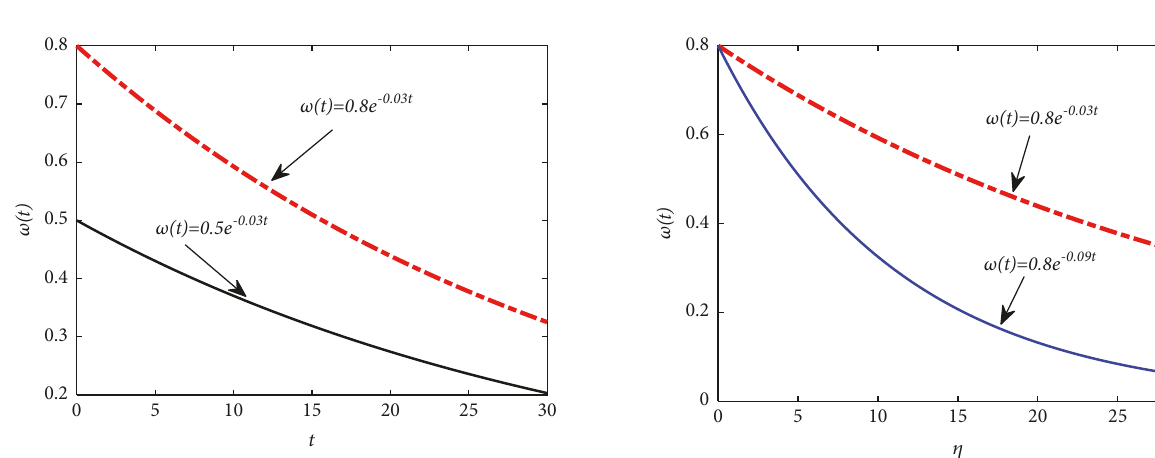
𝑇 𝐼(𝑝(𝑡), 𝑡)𝑑𝑡 , and 𝐶 0